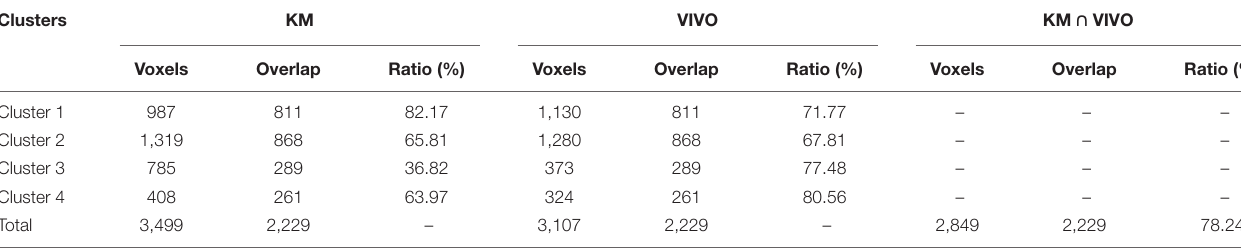
TABLE 2 | The overlapping ratios of the parcellations of the two datasets. Clusters